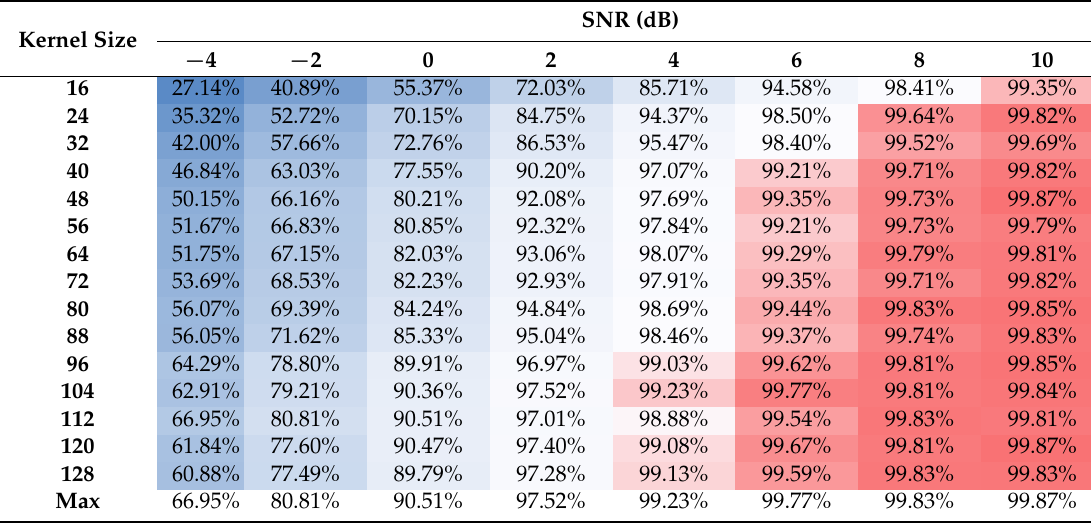
Table 5. Results for WDCNN with AdaBN under different noisy environment.